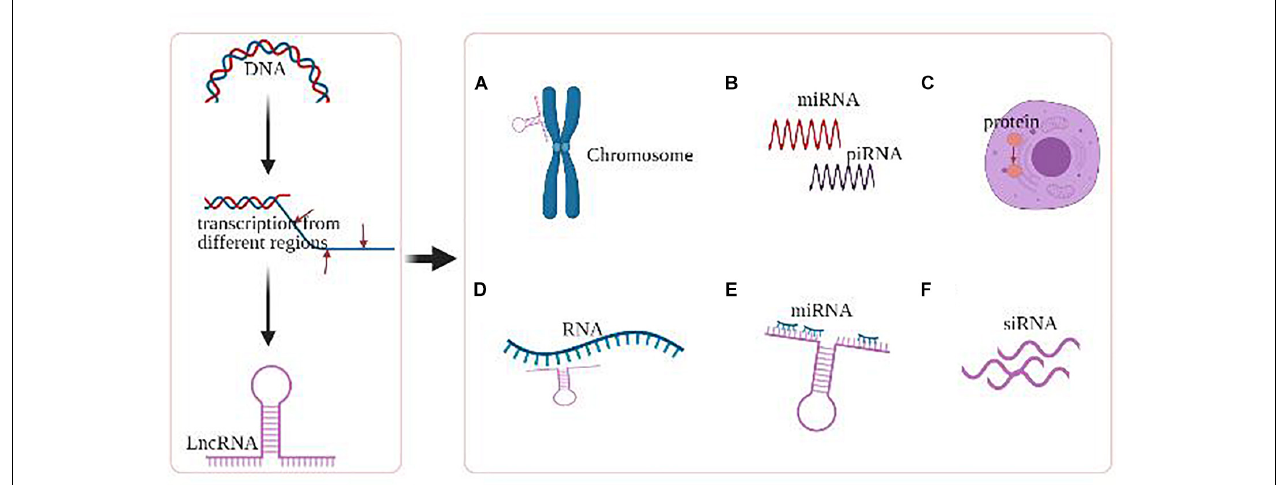
FIGURE 2 | Major epigenetic regulations of lncRNA. (A) LncRNAs mediate chromosomal remodeling. (B) LncRNAs act as small RNA (miRNA, piRNA) precursor. (C) LncRNAs alter cellular localization of proteins. (D) LncRNAs involve in the transcriptional regulation of genes. (E) LncRNAs act as miRNA sponge. (F) LncRNAs produce endogenous siRNAs with the involvement of the dicer